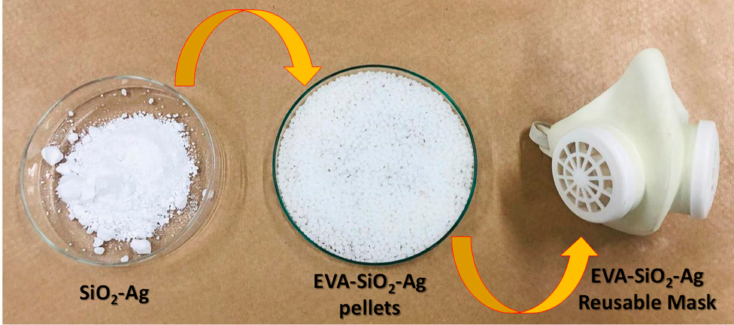
Figure 10. Reusable mask manufactured using the EVA-SiO 2 -Ag composite.